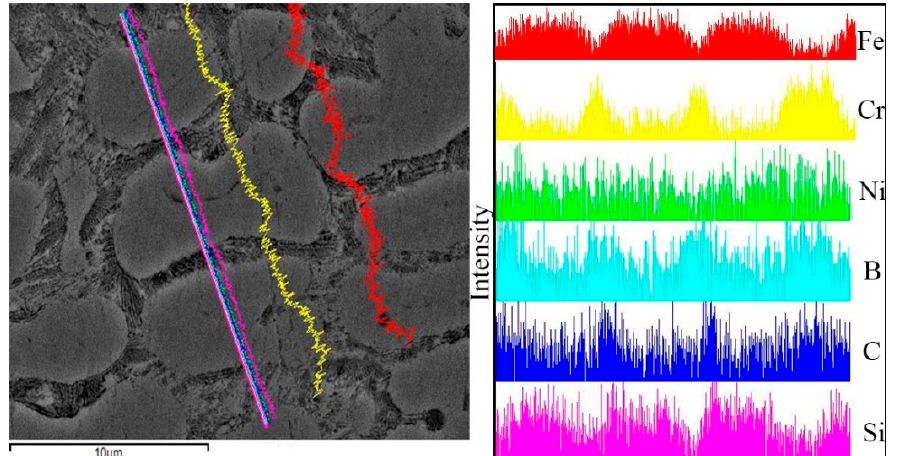
Figure 8. Linear elemental distributions of the microstructure of Coating 1. Coatings 2019 , 9 , x FOR PEER REVIEW